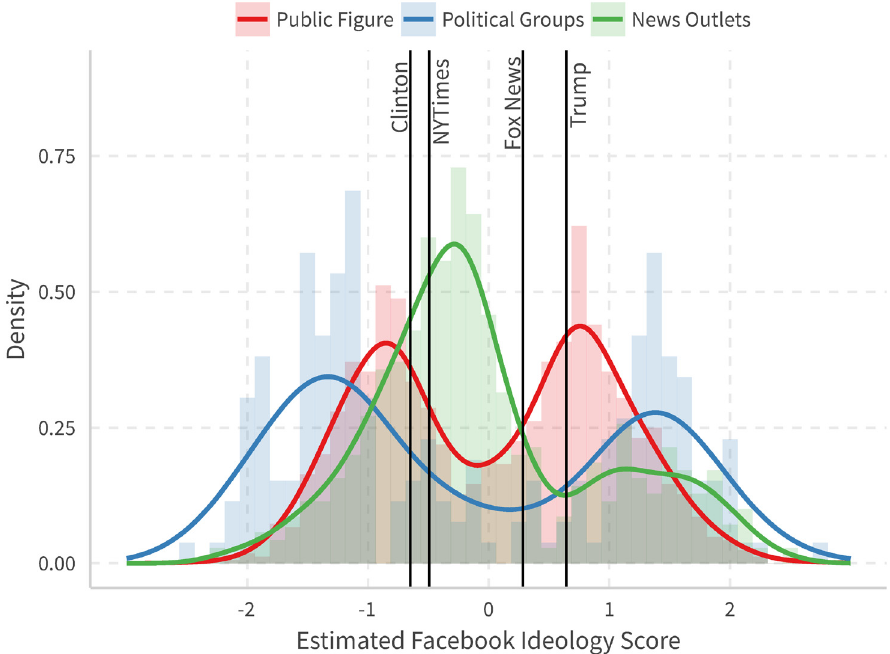
Fig 3. Histogram and density for different page